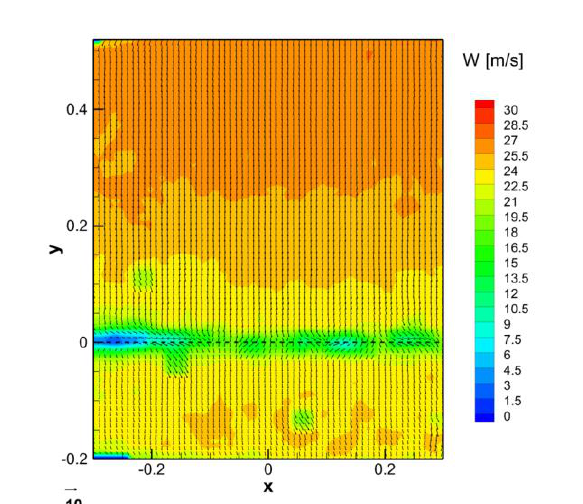
Fig. 10. Mean of-plane velocity component with in-plane velocity vector components. Re = 1M.